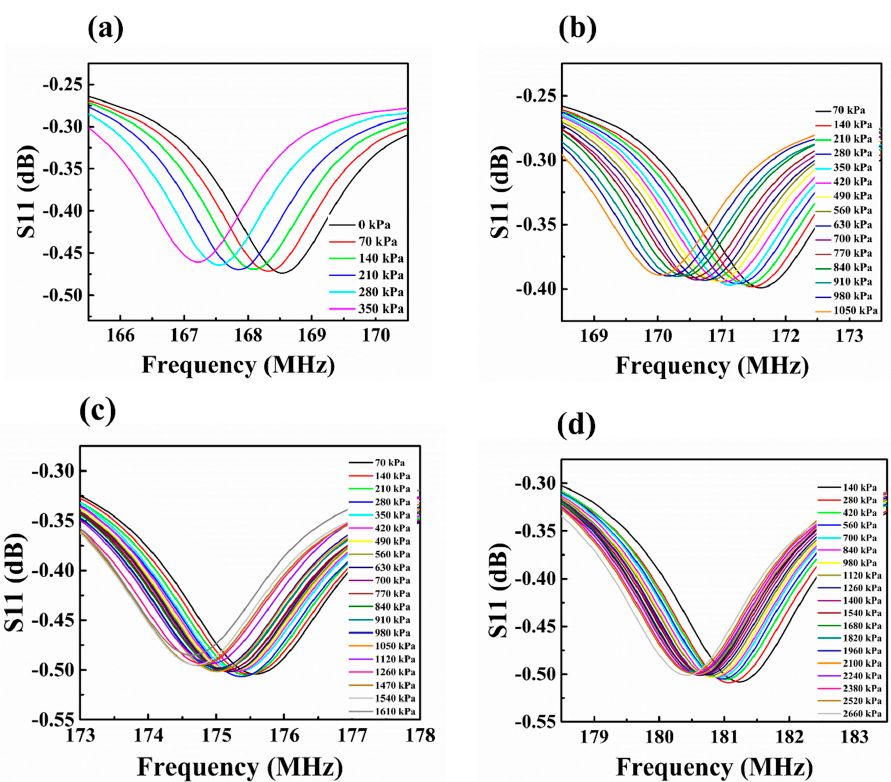
Figure 7. Wireless signal response of the pressure sensors under different pressures: ( a ) S3; ( b ) S5; ( c ) S7; ( d ) S9.